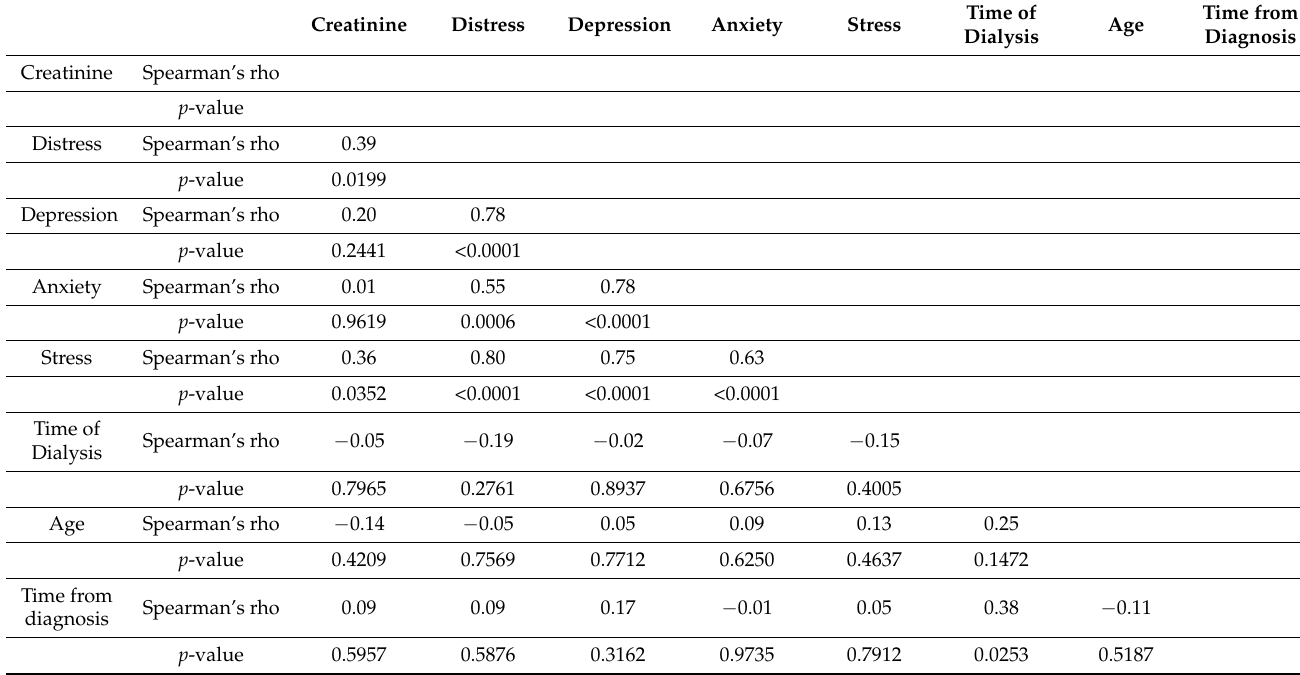
Table 4. Correlation matrix (Spearman test) comparing emotional dimensions and creatinine levels.